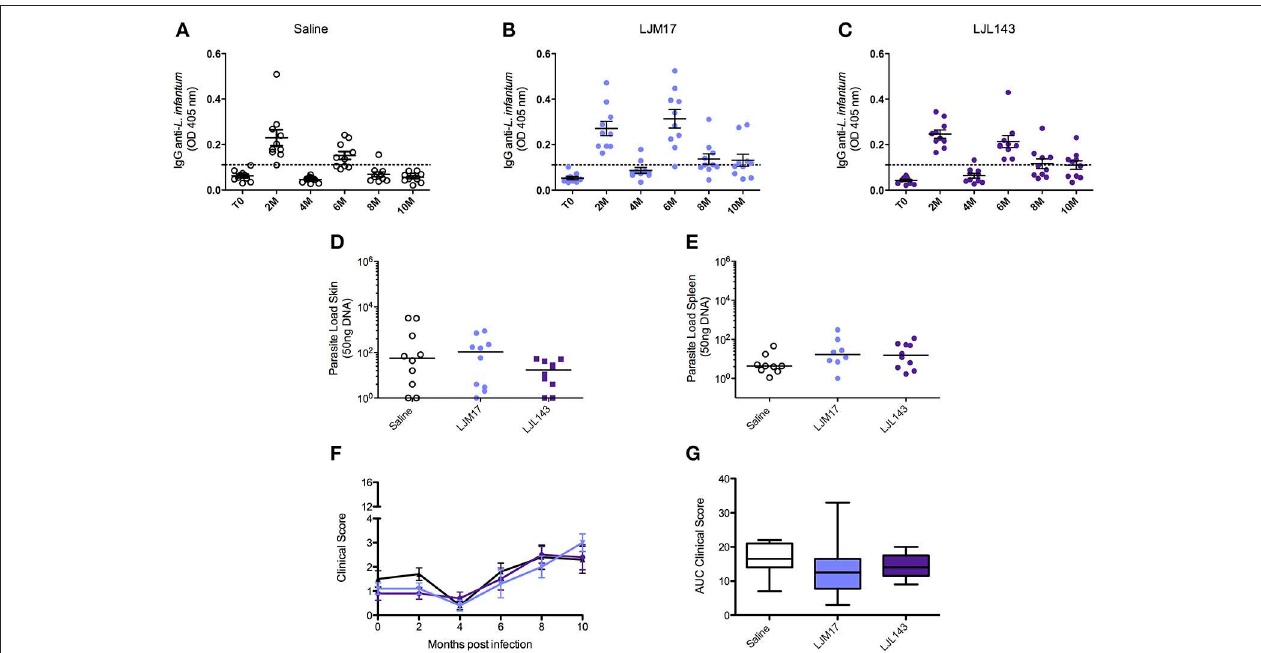
FIGURE 2 | Analysis of humoral immune response in canine sera, parasite loads and clinicial evaluation after challenge. Beagle dogs ( n = 10 animals/group; total of 30 dogs) were immunized following vaccination strategies described in the methodology section. Thirty days after the final immunization, all dogs were challenged with L. infantum in the presence of L. longipalpis saliva. Sera from the immunized and control animals were collected at T0 (15 days after immunization),and every 2 months until 10 months after infection, to detect anti- Leishmania IgG antibodies. (A) Control, LJM17 (B), and LJL143 (C) immunized dogs T0 to 10 months after infection. The dotted line represents the cutoff point (mean plus 2x standard deviation = 0.036) obtained from sera of healthy dogs prior to infection. Samples of skin (D) and spleen (E) from immunized and control animals were collected at 2 months post infection for parasite load quantification by real time PCR. Clinical evaluation score curves (F) and Area Under Curve (AUC) (G) from T0 to 10 months after infection. Statistical analysis was performed using the Kruskall-Wallis test with Dunns